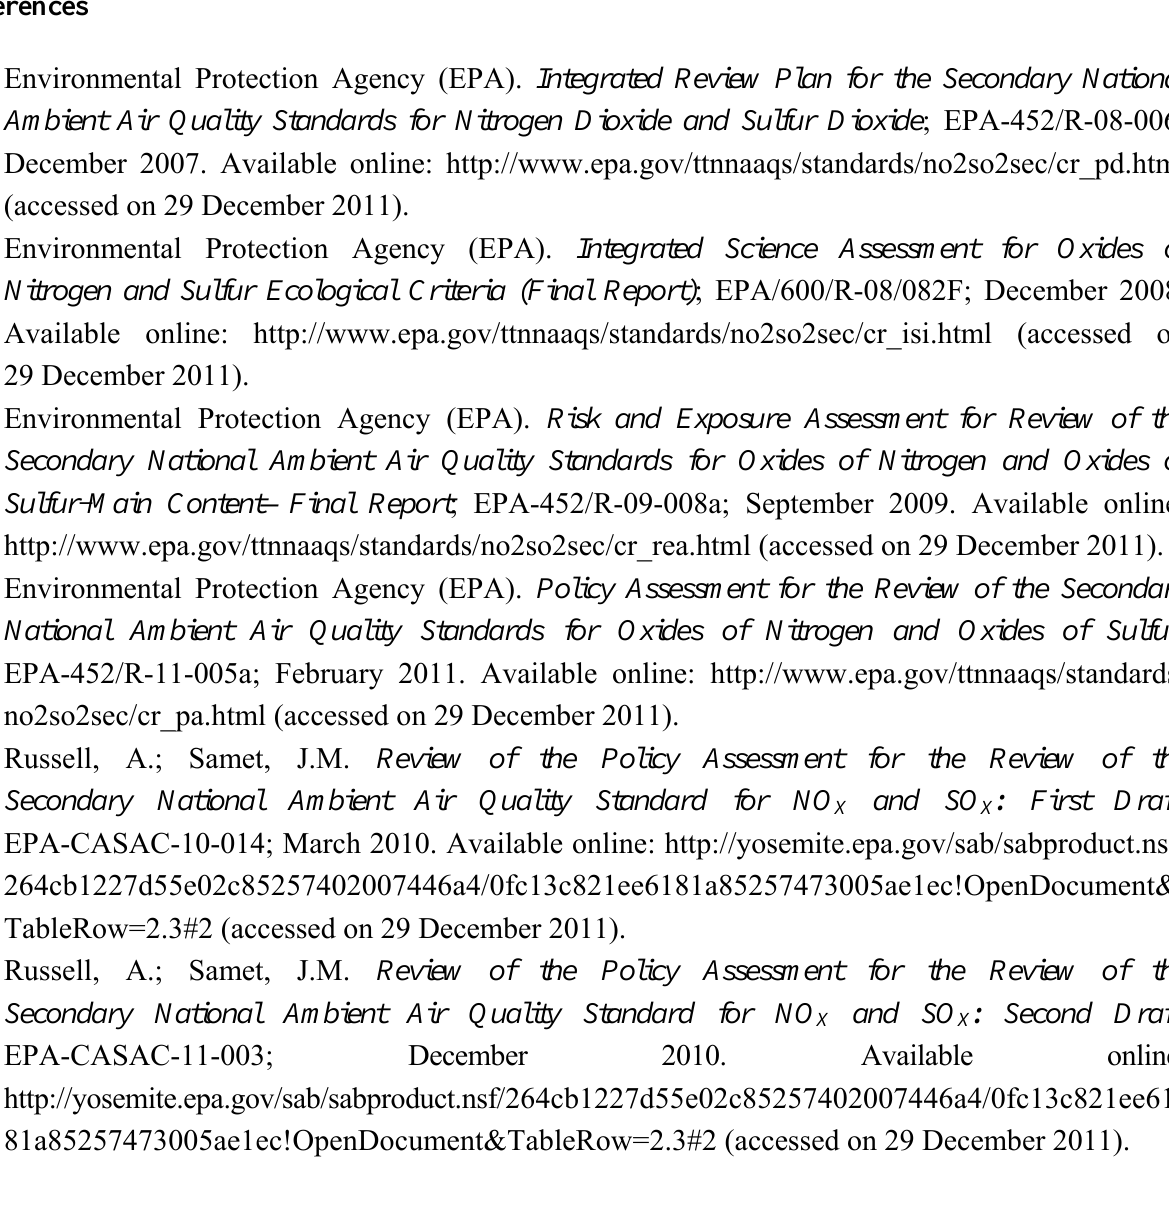
TableRow=2.3#2 (accessed on 29 December